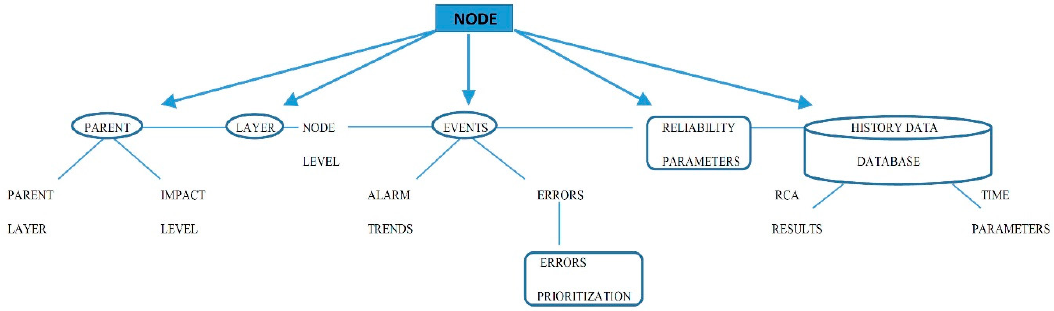
Figure 2. Possible node model entities.